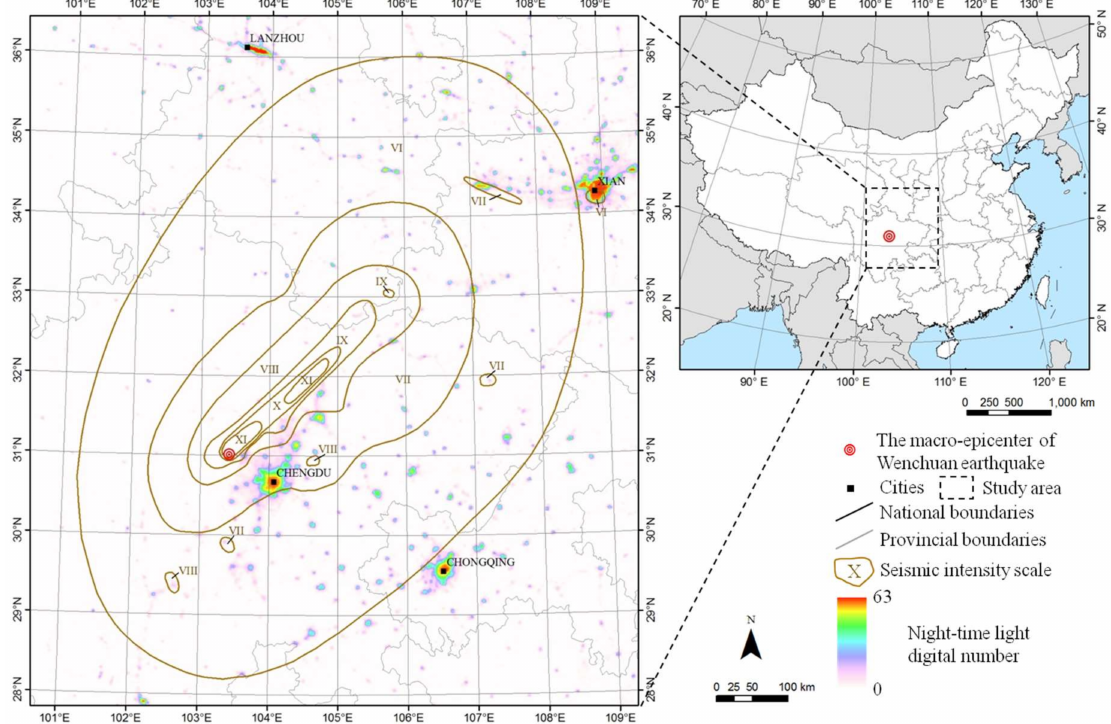
Figure 1. The study area of the research. The seismic intensity scale is the Chinese seismic intensity scale. The distribution of the Wenchuan earthquake seismic intensity comes from the field survey from the China Earthquake Administration. The NTL image used in the figure is obtained in 2008 by